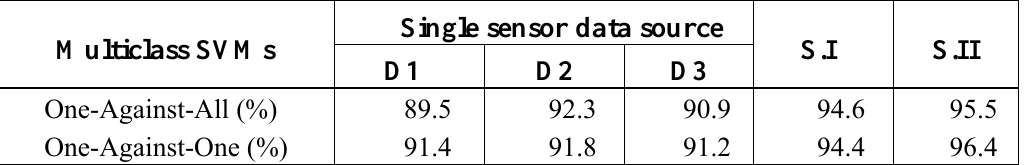
Table 4. Comparison of Classification